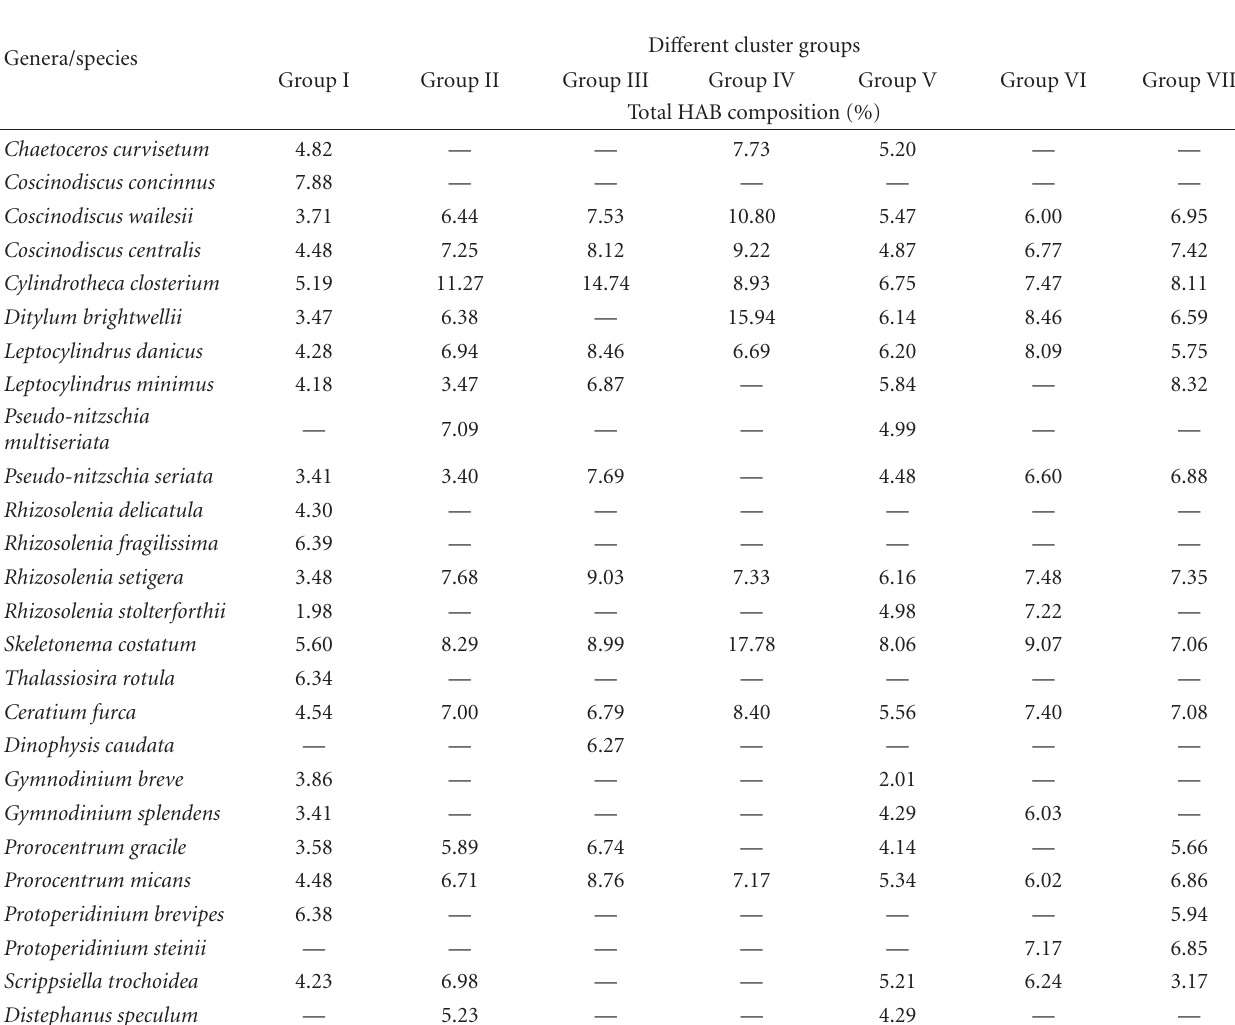
Table 2: Percent compositions of dominant HAB species in each group outlined by the cluster analysis based on SIMPER analysis.